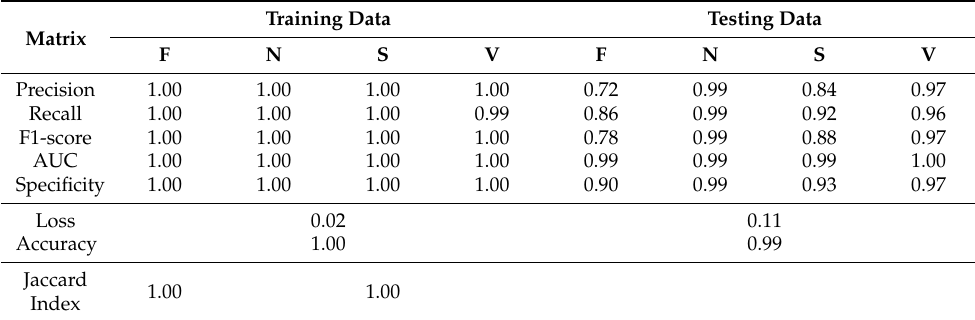
Table 2. Overall performance matrix of the CNN-GRU mode on the validation dataset. Matrix